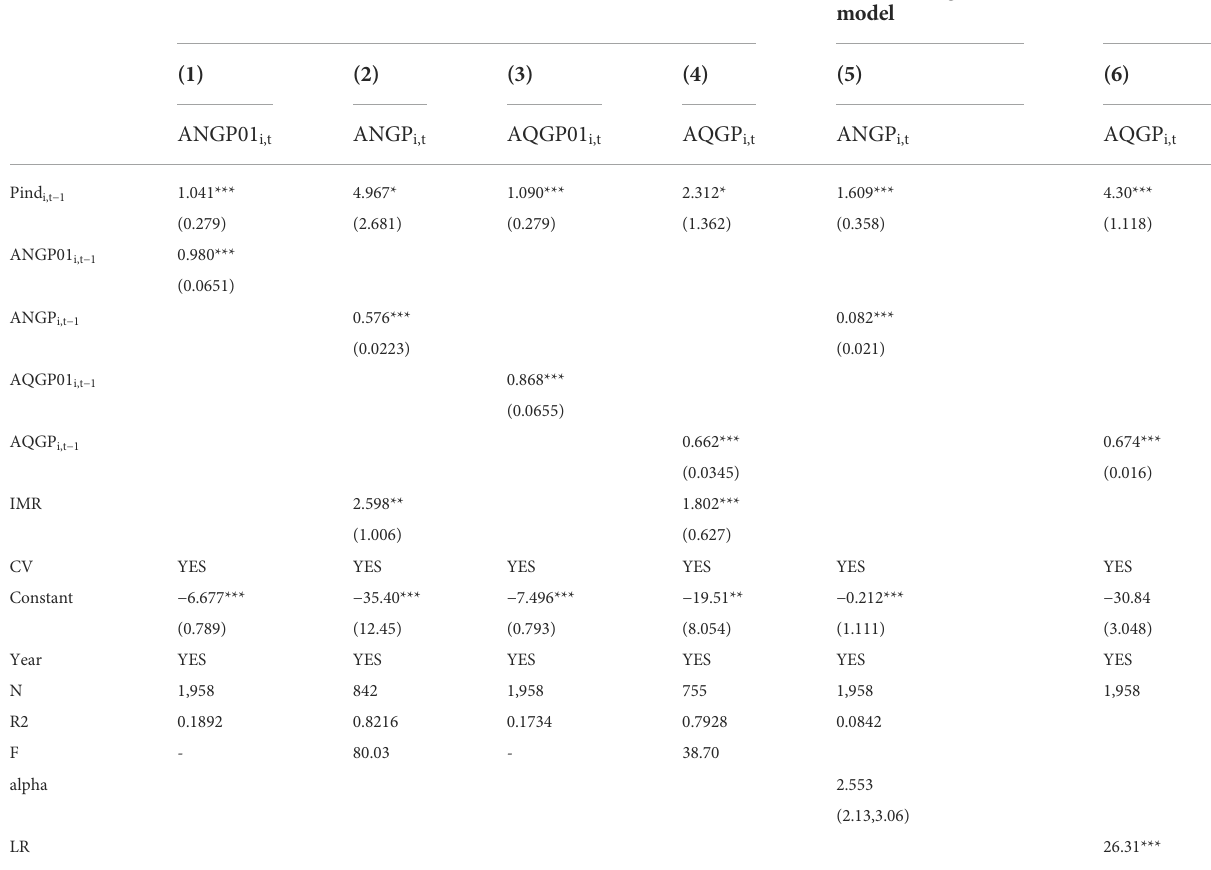
TABLE 5 Robust tests — Model